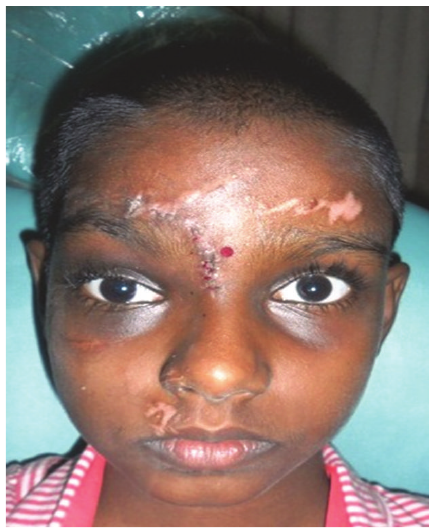
Figure 5: Two weeks after